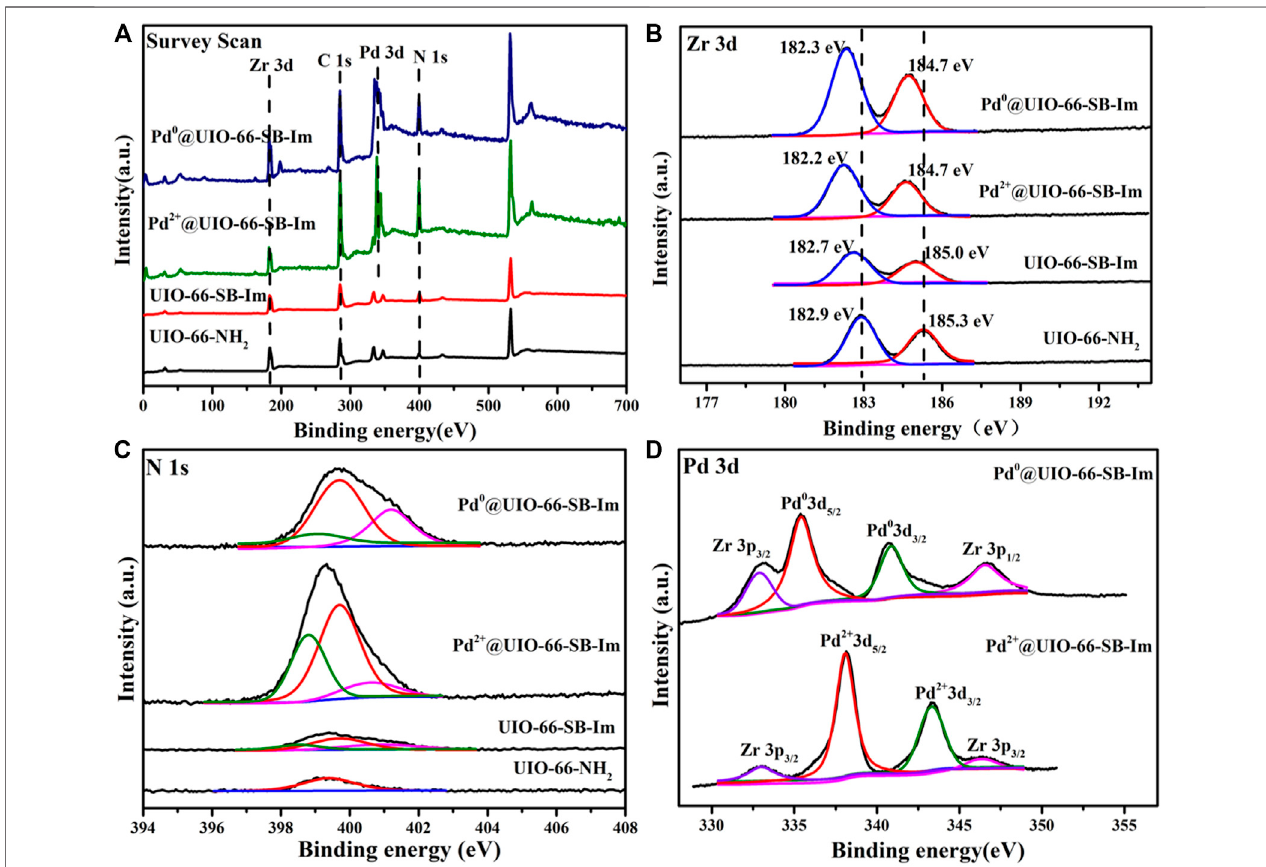
FIGURE 5 | (A) Survey scan, (B) Zr 3d, (C) N 1s, and (D) Pd 3d X-ray photoelectron spectroscopy (XPS) spectra of UIO-66 – NH 2 , UIO-66 – SB – Im, Pd 2+ @UIO- 66 – SB – Im, and Pd 0 @UIO-66 – SB – Im.